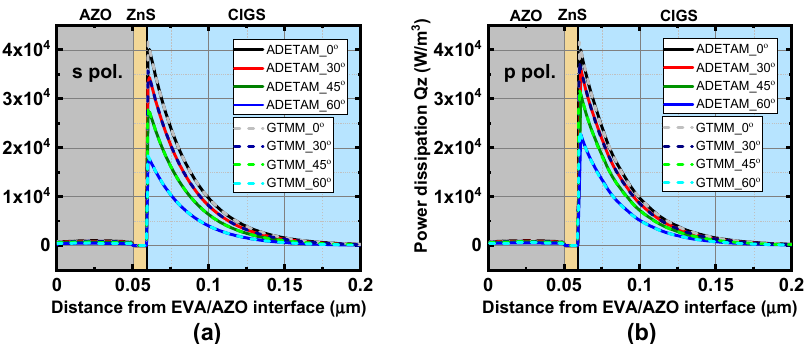
Figure 4. Calculated spectral spatial distributions of light absorption obtained by the ADETAM and the GTMM when ( a ) s- and ( b ) p-polarized input plane wave with the wavelength of λ = 400 nm and the surface power density of 5.57 W/m 2 has the incidence angle of θ 0 =0 ◦ , 30 ◦ , 45 ◦ , and 60 ◦ . The calculated spatial absorption profiles obtained by the ADETAM are well matched with the exact analytical results calculated by the GTMM.